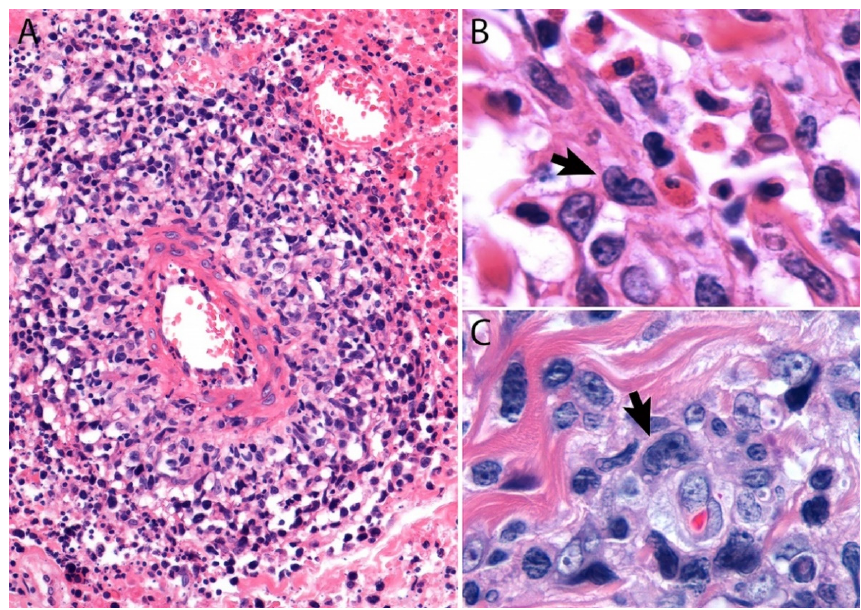
Figure 13. Primary cutaneous ALCL. ( A ) Diffuse atypical lymphoid infiltrate with pleomorphic cells with angiocentric growth and focal dermal necrosis. ( B , C ) Many cells have eccentric, kidney-shaped, or lobulated nuclei with small-to-medium size nucleoli and abundant eosinophilic cytoplasm, also known as “hallmark” cells (arrows).